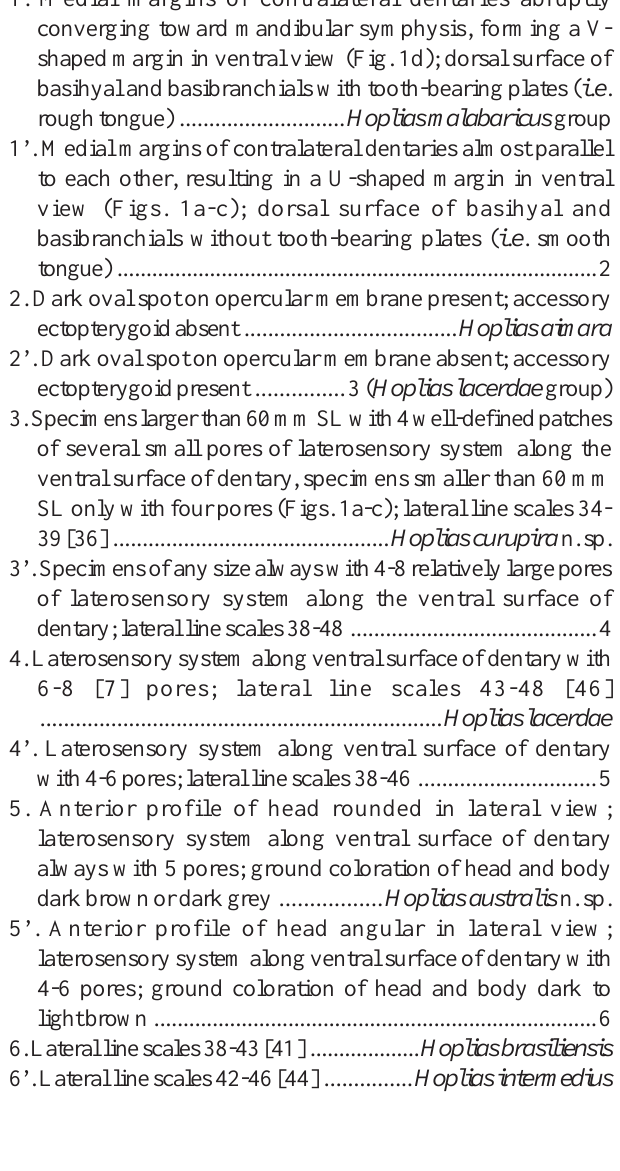
Holotype. BRAZIL. Santa Catarina State. Uruguay basin: MCP 40175, 220.0 mm SL, rio das Antas, rio do Ouro drainage, on Formosa do Sul-Irati road, Formosa do Sul, 26º38’55’’S 52º48’05’’W, 25 Jan 2006, C. A. Lucena, E. Pereira, V. Bertaco & J. P. Silva. Paratypes. ARGENTINA. Misiones. Uruguay basin: MCP 13318, 2, 41.9-42.2 mm SL, arroyo Itacaruaré, 27º53’S 55º17’W, 28 Jun 1989, E. Lerner; MCP 13320, 1, 59.3 mm SL, arroyo Santa Maria, 27º56’S 55º27’W, 28 Jun 1989, E. Lerner. BRAZIL. Rio Grande do Sul State. Uruguay basin. MCP 18561, 1, 200.6 mm SL, rio Dourado between Três Barras and Mariano Moro, Mariano